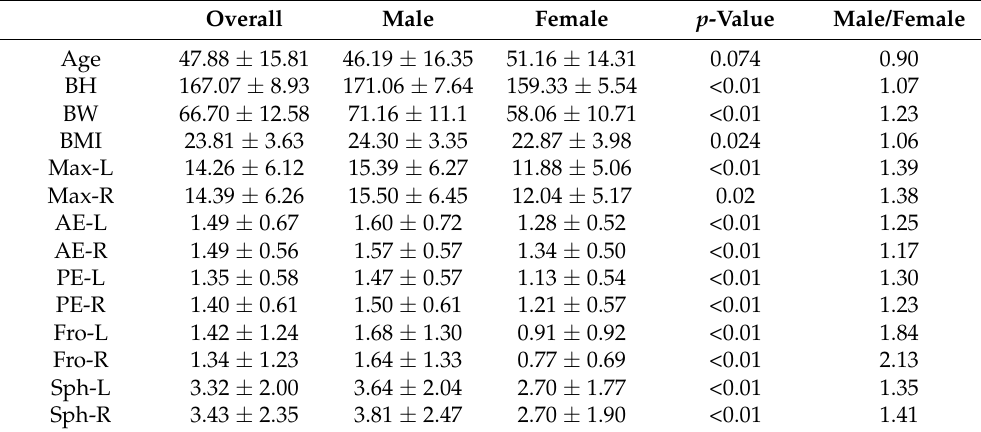
Figure 2. Examples of segmentation and 3D reconstruction of the ( A ) frontal, ( B ) maxillary, ( C ) ante- rior and posterior ethmoid, and ( D ) sphenoid sinus. R/L: right/left side, AE/PE: anterior/posterior ethmoid sinus. Table 3. Mean values of the metrical characteristics and volume dispersion by sex, and results of the comparison between